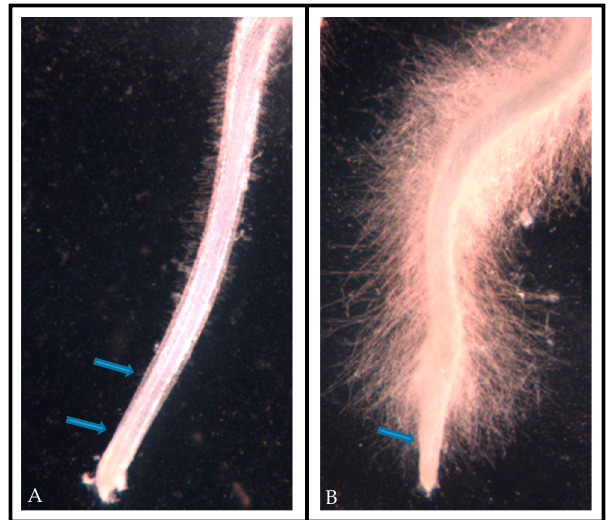
Figure 2. Divergent hairy root development in conventional variety “Kopious” (A) and drought-tolerant variety “Solar” (B) when the roots emerged from seedlings immersed in water.